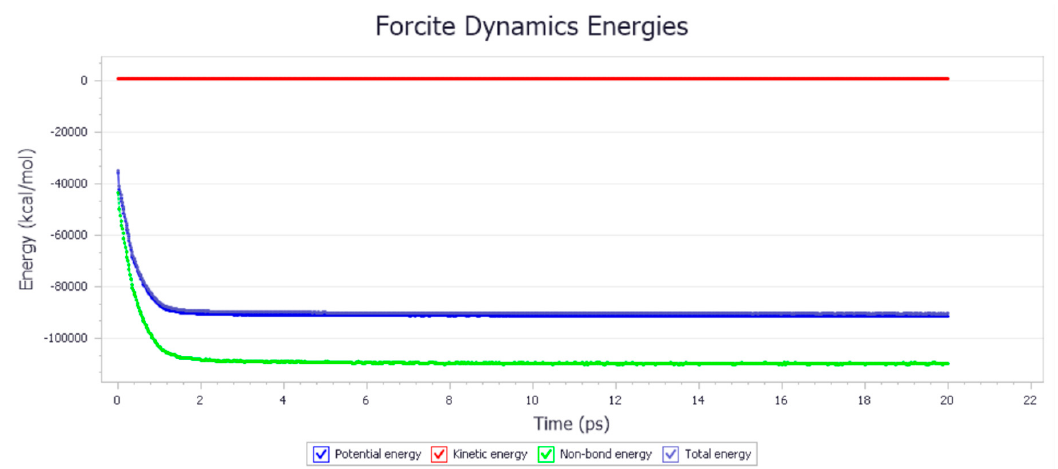
Figure 4. The change of energy with time in the molecular dynamics simulation.